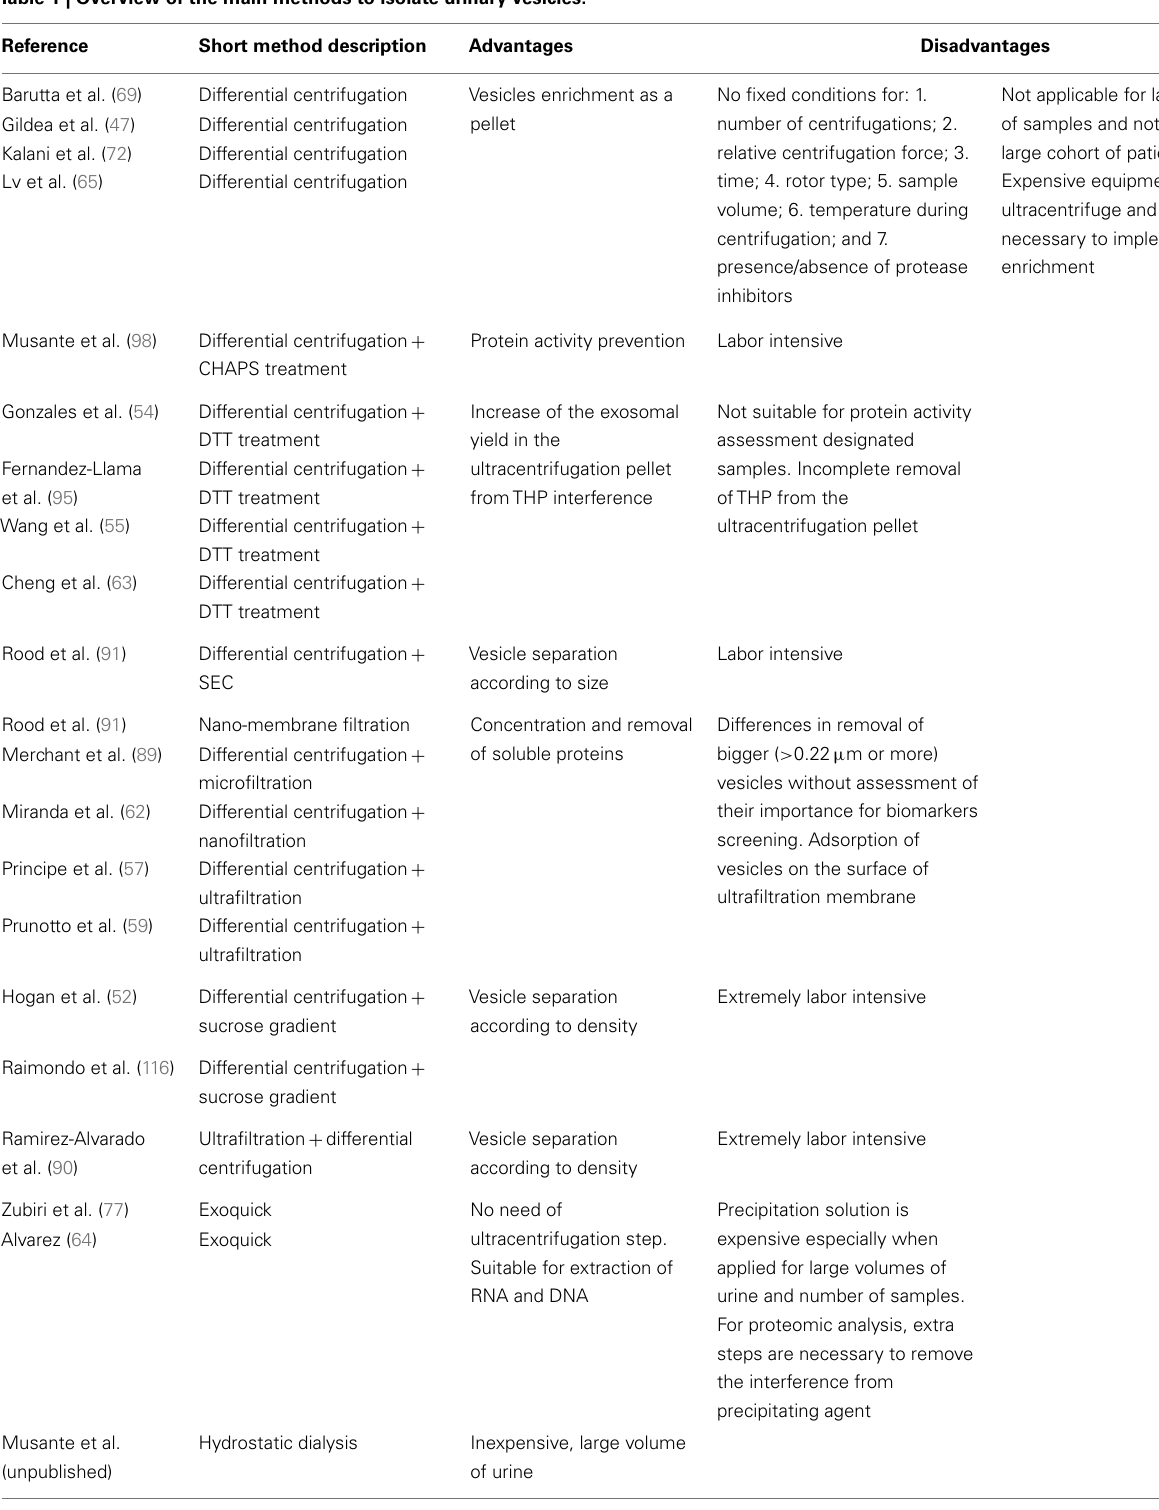
Table 1 | Overview of the main methods to isolate urinary